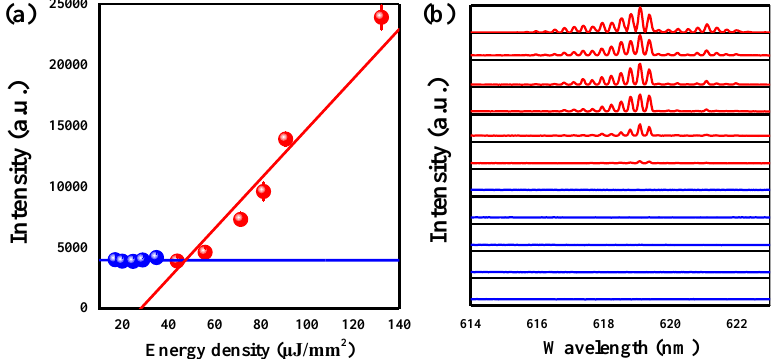
Figure 6. ( a ) Output laser intensity as a function of the energy density (light–light curve). ( b ) Evolution of the normalized output intensity as a function of wavelength and pump power.